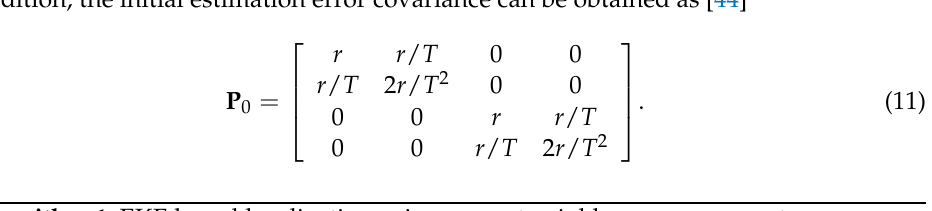
Algorithm 1: EKF-based localization using nearest neighbor